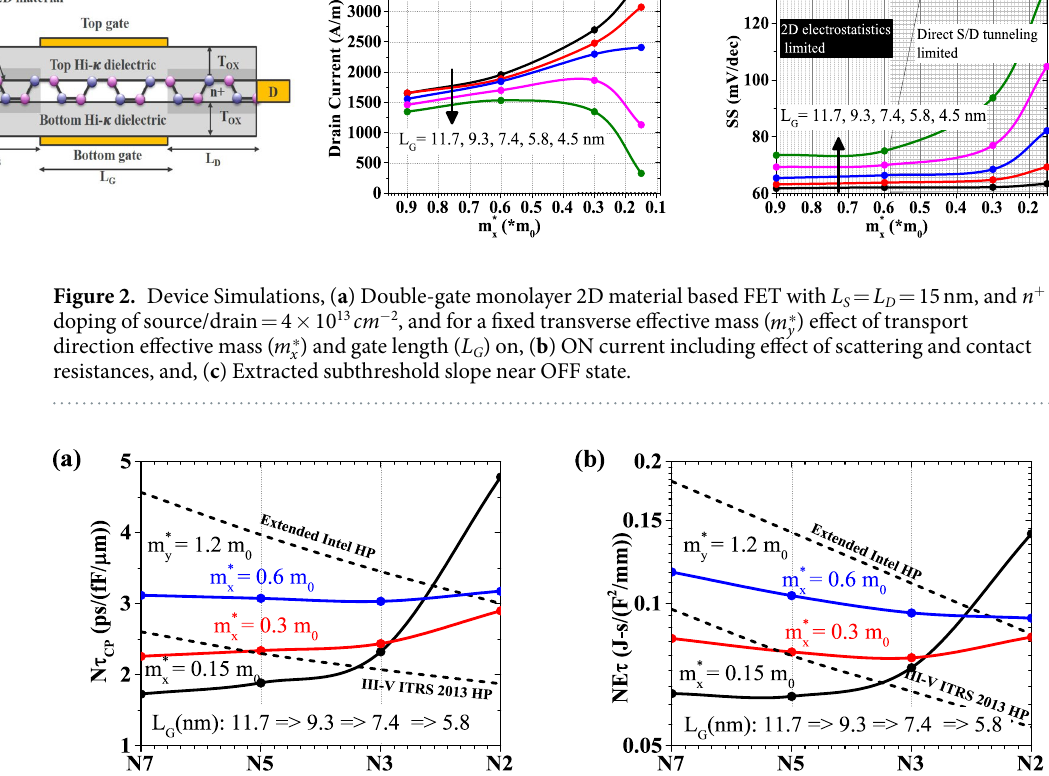
⁎ m = 0.15 m = 1.2 m 0 , 0 ) w.r.t. III–V ITRS 2013 HP and Extended Intel HP x y